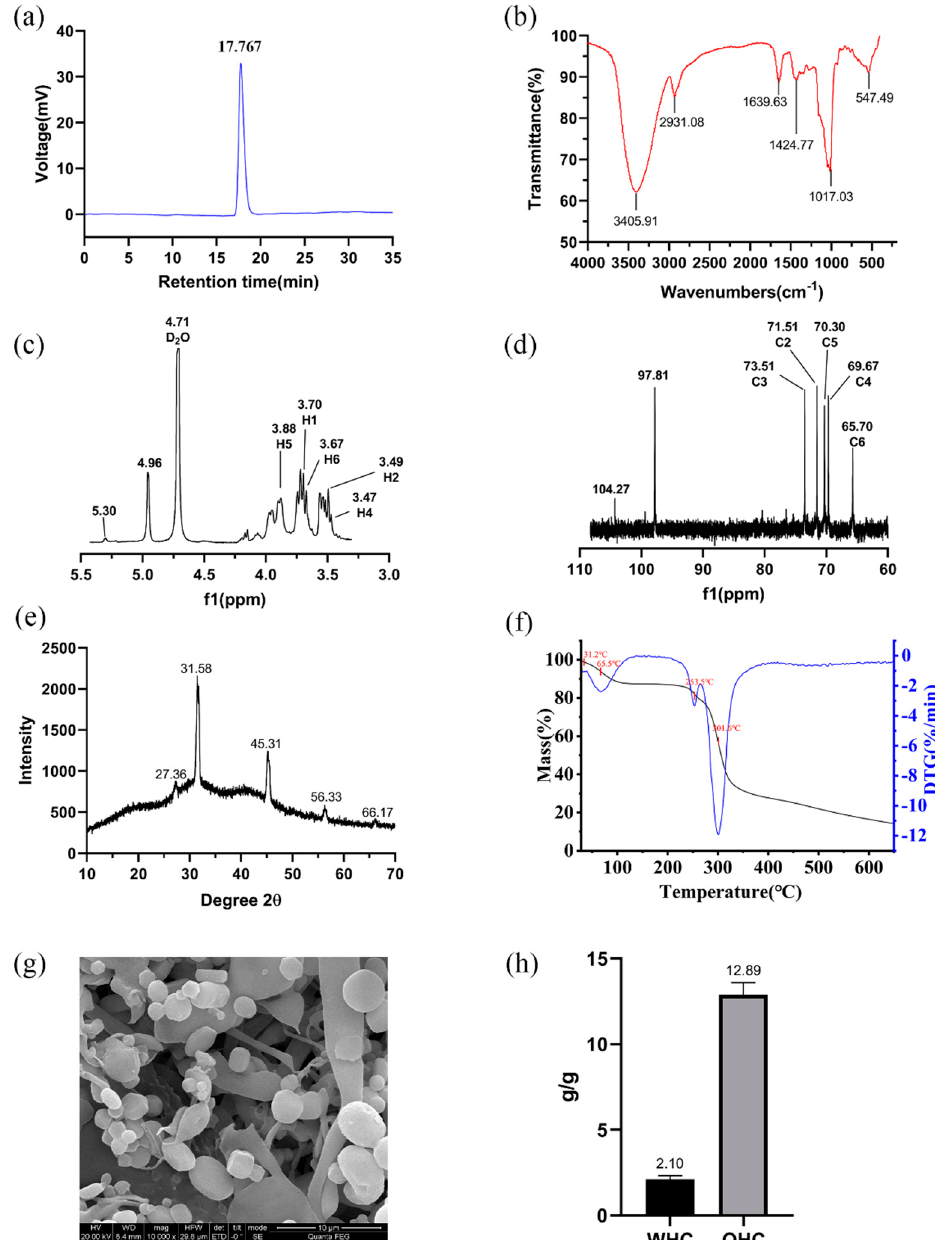
Figure 3. The physicochemical characterization of LSEP: GPC chromatogram of LSEP ( a ), FT-IR spectrum of LSEP ( b ), 1 H NMR spectrum of LSEP ( c ), 13 C NMR spectrum of LSEP ( d ), XRD pattern of LSEP ( e ), thermal analysis of LSEP ( f ), SEM image of LSEP magnification 10,000 × ( g ), water holding capacity, and oil holding capacity of LSEP ( h ).